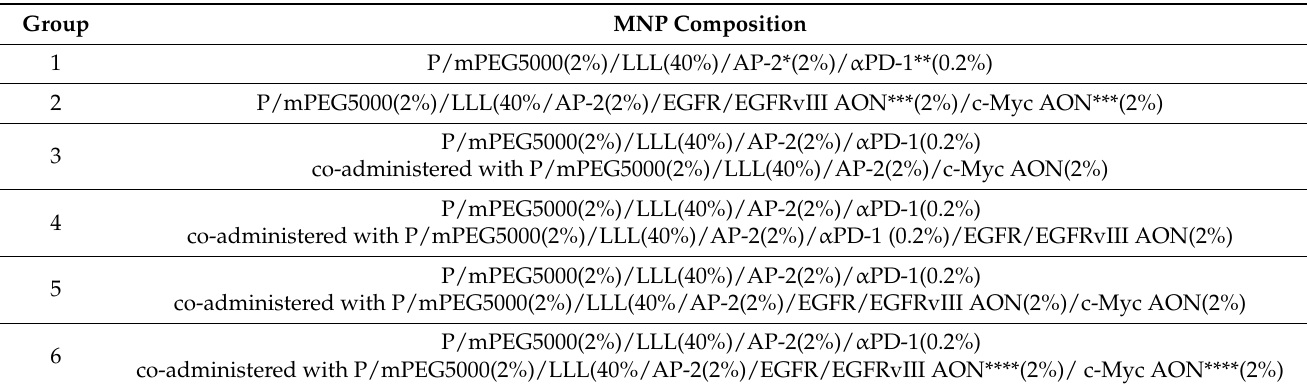
Table 2. List of MNPs used for syngeneic mouse